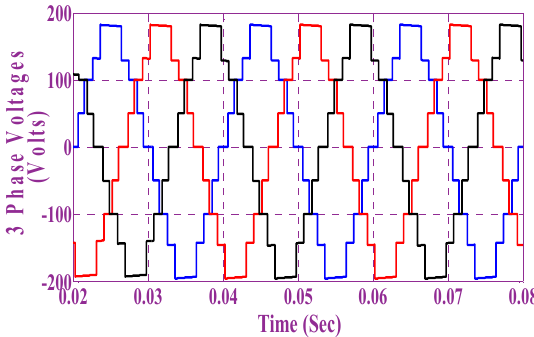
Figure 10. Three-phase voltages of the nine-level SCMLI.